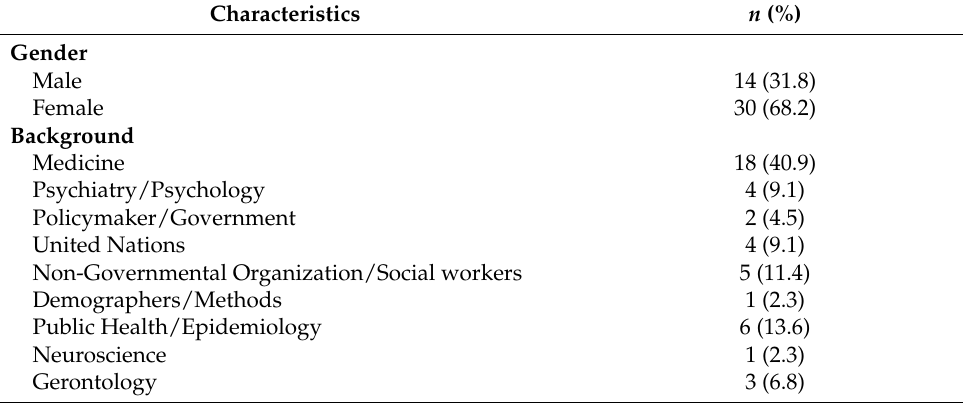
Table 1. Demographic characteristic of participants ( n =